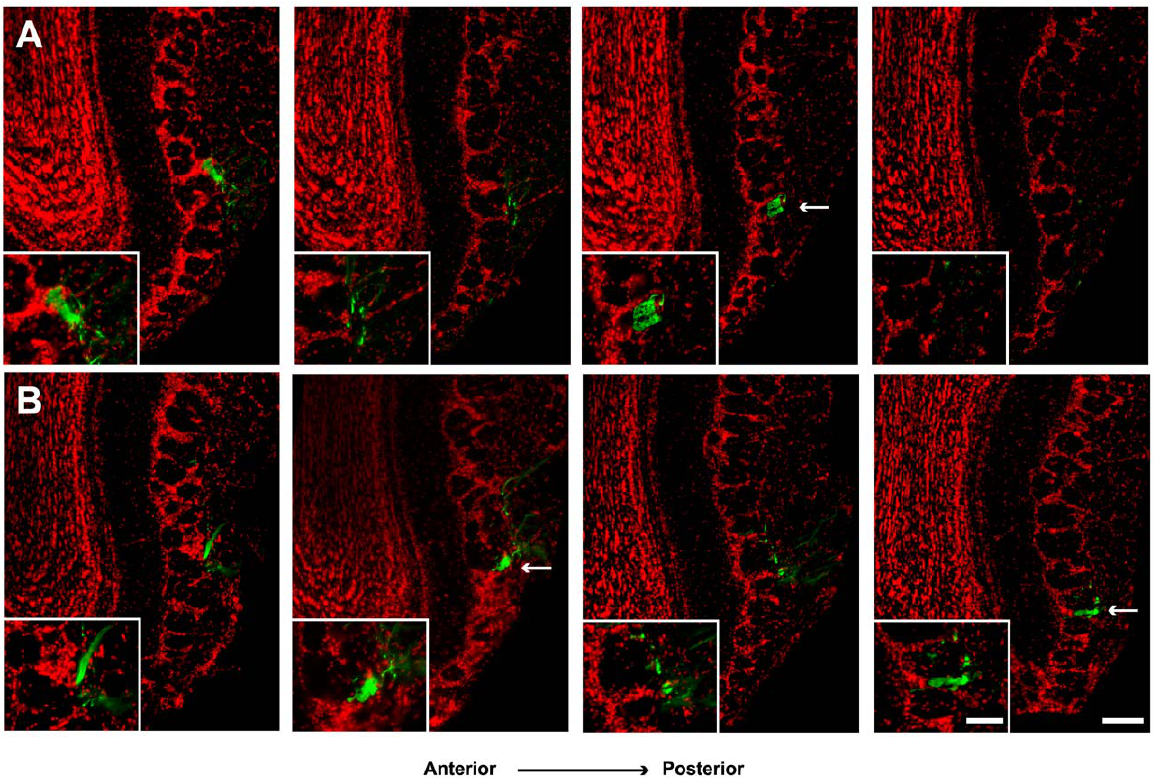
Figure 5. I7 glomerular circuit is restored 45 days after methimazole-induced lesion. Representative images of serial coronal slices of bulbs from I7-IRES-tauGFP mice are shown. A , The projection of GFP-positive axons into the antero-ventro-lateral aspect of control OB, it can be observed that they coalesce in one lateral glomerulus (arrow). B , 45 days post-lesion the axons project mainly into two adjacent locations (arrows) in the same area shown in A. Insets at the bottom show a close-up of GFP fibers. Space between slices is 40 m m. Scale bar 100 m m and 50 m m for